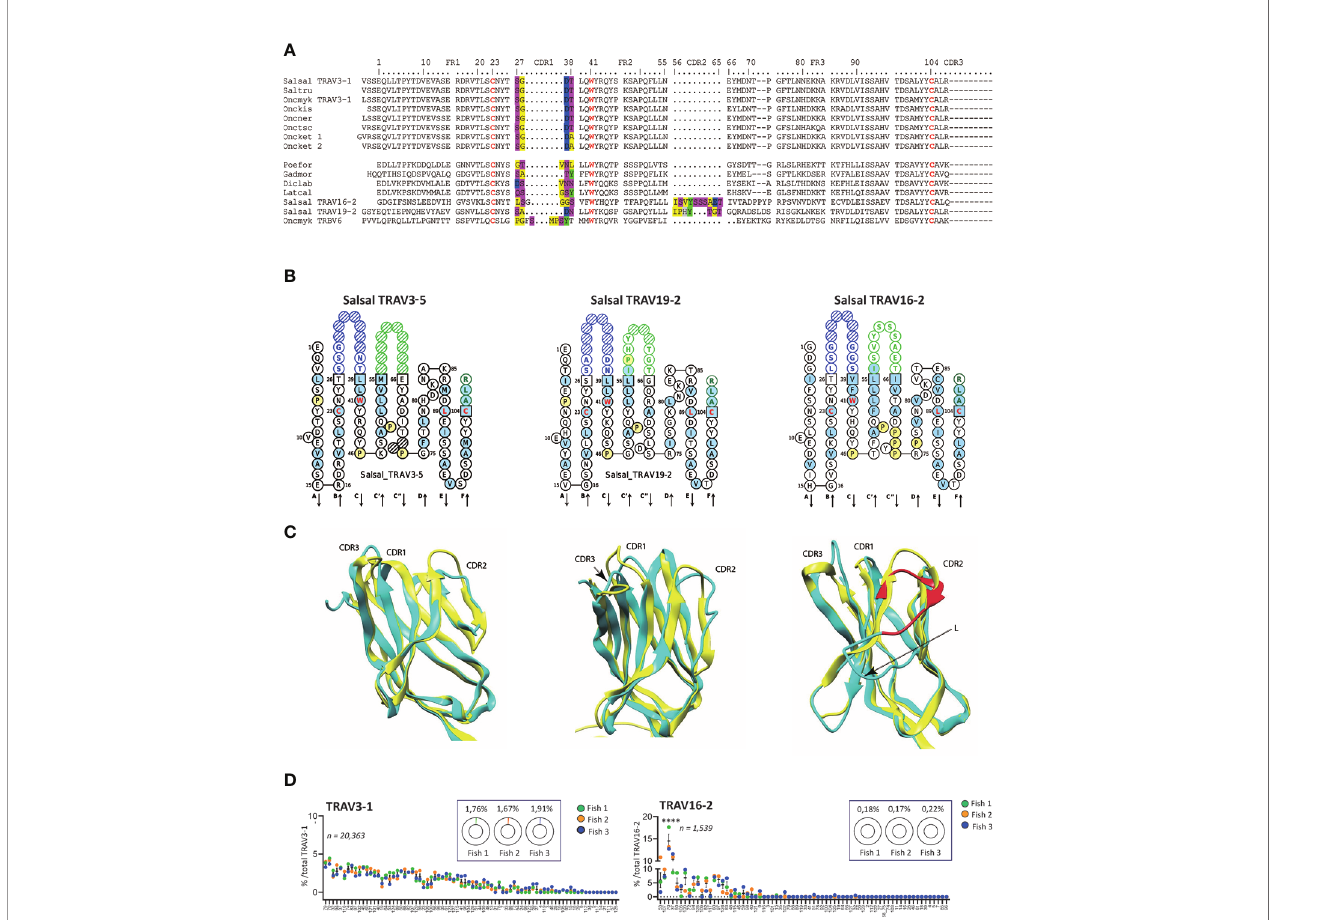
FIGURE 6 | Variations of CDR2-IMGT across salmonid TRAV. (A) Multiple alignment of selected TRAV (TRAV22, TRAV16, TRAV19) protein sequences from Atlantic salmon (Salsal) and rainbow trout (Oncmyk) with sequences presenting similar features from other Salmonids and other teleosts. (B) IMGT Collier de Perles of Atlantic salmon TRAV3-5, TRAV19-2, TRAV16-2, illustrating CDR2-IMGT length variation. (C) Salmon TRAV3, TRAV19, and TRAV16 (cyan) aligned to human TR B7 alpha chain V domain. Note the lack of CDR2 in salmon TRAV3. Salmon TRAV19 is shown for comparison of CDR2 modelling, and TRAV16 domain for its very long CDR2 region (in red) that induces an additional loop (L) in the model, which may not re fl ect the reality but illustrates the constraint on the domain. (D) Relative TRAJ usage shown as percentage of total reads containing a speci fi c TRAJ gene for TRAV3-1 or TRAV19-9 containing productive rearrangements. Individual TRAJ genes are shown on the X-axis, average number of reads from each fi sh containing the indicated TRAV-TRAJ combination are shown ( fi sh 1 is in green, fi sh 2 in orange and fi sh 5 in blue). The total number of sequences for each TRAV is indicated and the inlaid box shows the average representation of each TRAV per total number of productive rearrangements from each fi sh. Atlantic salmon, Salsal; rainbow trout, Oncmyk; Brown trout, Saltru; Coho, Onckis; Chinook salmon, Onctsc; Chum salmon, Oncket; Sockeye, Oncner; African molly, Poefor; Atlantic cod, Gadmor; barramundi perch,